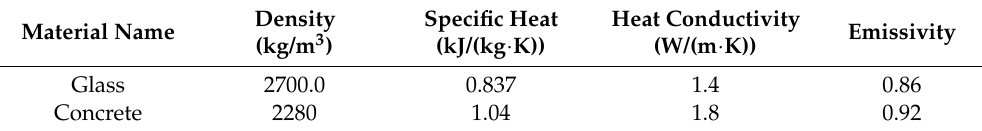
Figure 3. Physical model of the combustion compartment. Table 2. Thermal physical parameter settings for glass